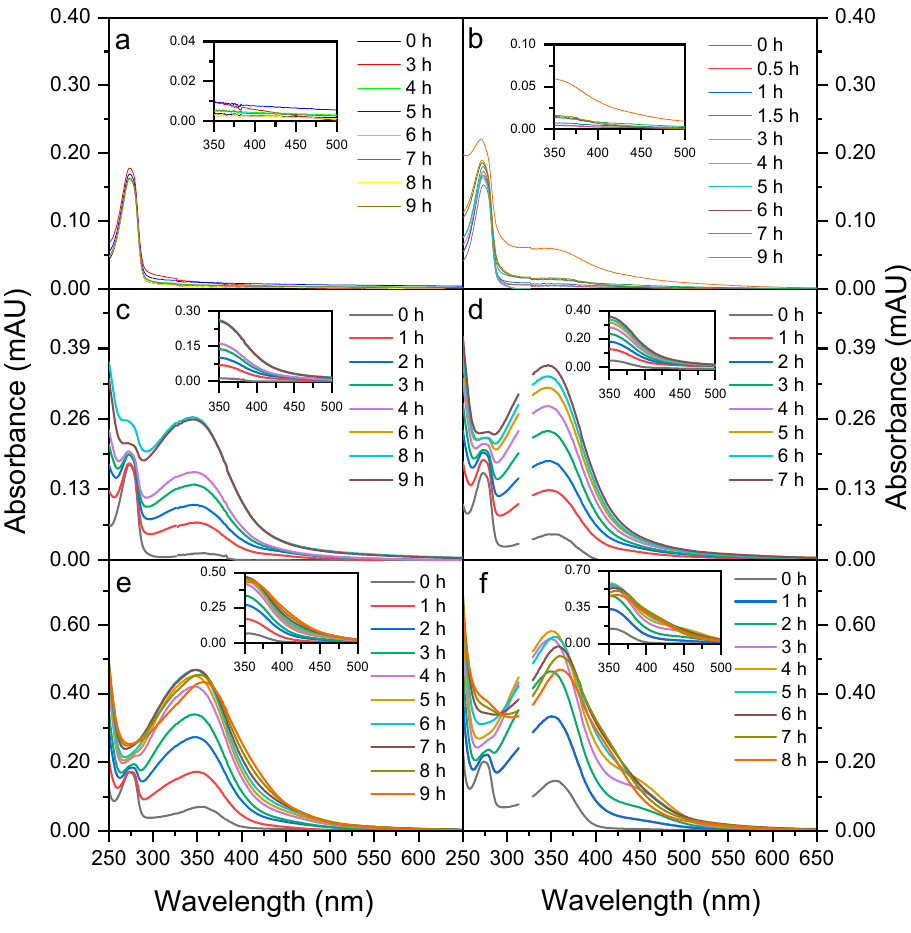
Figure 3. Absorption spectra of the reaction mixture during the photolysis of 3-methylcatechol (3MC) in aqueous NaNO 2 solutions (pH = 4–5, T = 25 °C) at different initial concentrations of NaNO 2 . The concentration of 3MC was always 0.1 mM, while the concentrations of NaNO 2 were 0 ( a ), 0.1 ( b ), 0.5 ( c ), 1 ( d ), 2 ( e ), and 5 mM ( f ). The discontinuation in the absorption spectra (d,f) is due to the issues with the instrument and does not affect the results in any way.